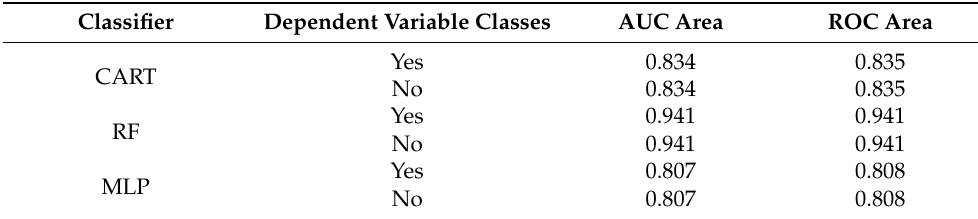
Figure 8. ROC curves for the two classes: Yes ( left figures), No ( right figures). Table 3. AUC and ROC